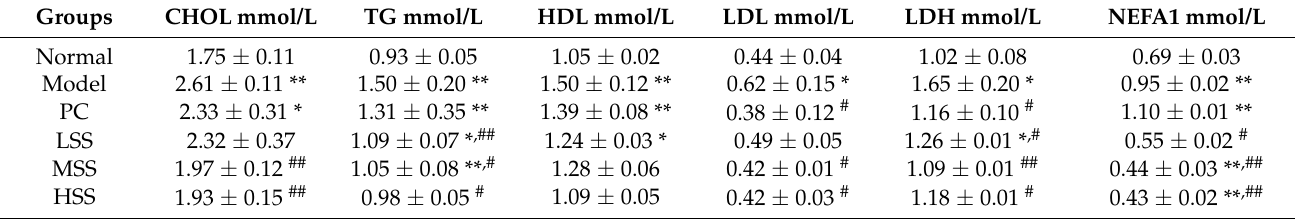
Table 3. Effect of oral SS administration on serum lipid levels in T2D